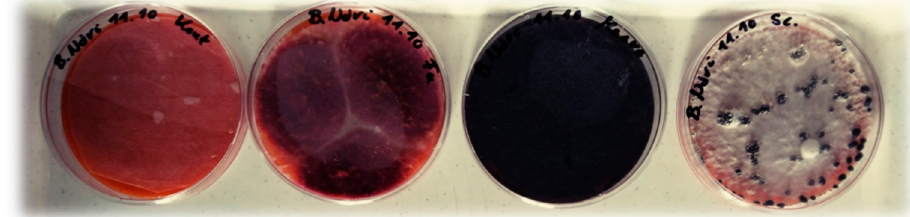
Figure 1. Food choice experiment to investigate different plant pathogen consumption of terrestrial isopods. From left to right, the image shows the pathogen-free control (later spontaneously infested by Aspergillus niger ), followed by Petri dishes with Fusarium solani , Macrophomina phaseolina , and Sclerotinia sclerotiorum (Photo: Nóra Balázs, Gödöll ő , Hungary, 2016). Petri dishes were kept at a 0–24 h light/dark regime and placed randomly on a tray at 22–25 °C. We monitored the loss of mycelia and propagules of the different fungi (Figures 2–4) and recorded the number of isopod individuals to survey their mortality.